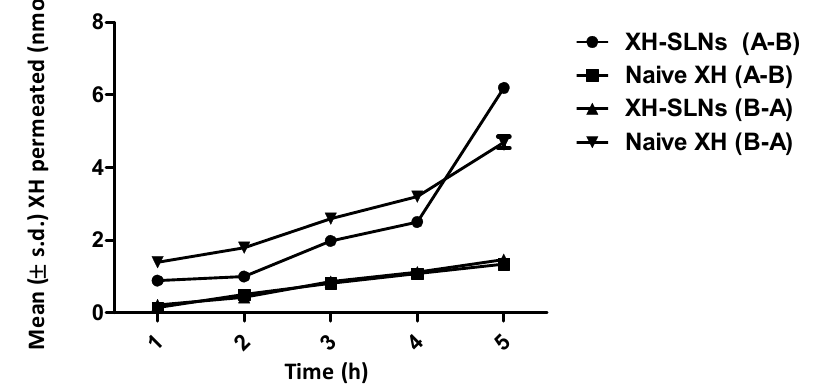
Figure 10. Permeability data of XH in Caco2 cell monolayer (number of replicates = 3).